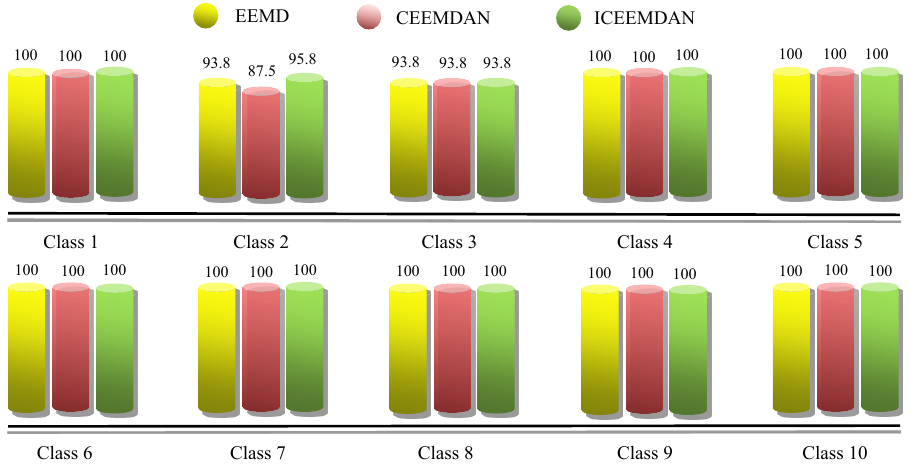
Figure 10. The average recognition rates by the three preprocessing algorithms for the ten bearing fault classes.